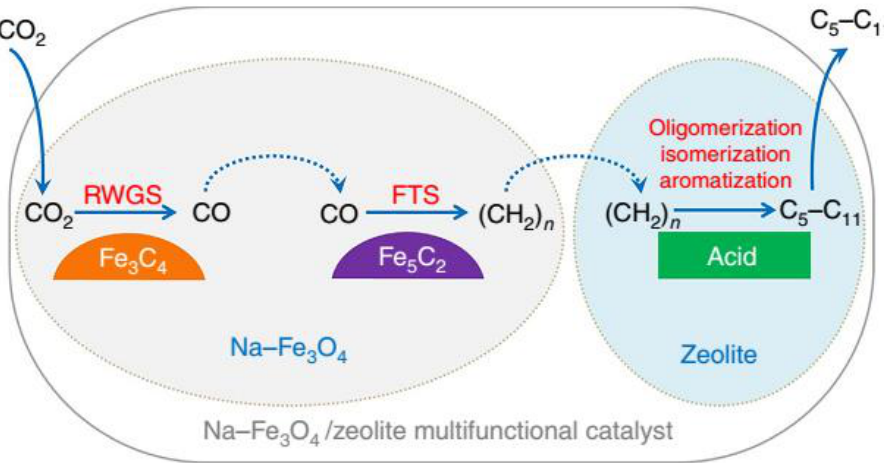
Figure 17. Reaction scheme for CO 2 hydrogenation to gasoline-range hydrocarbons, reproduced with permission from [76]. Copyright Nature Publishing Group, 2017.